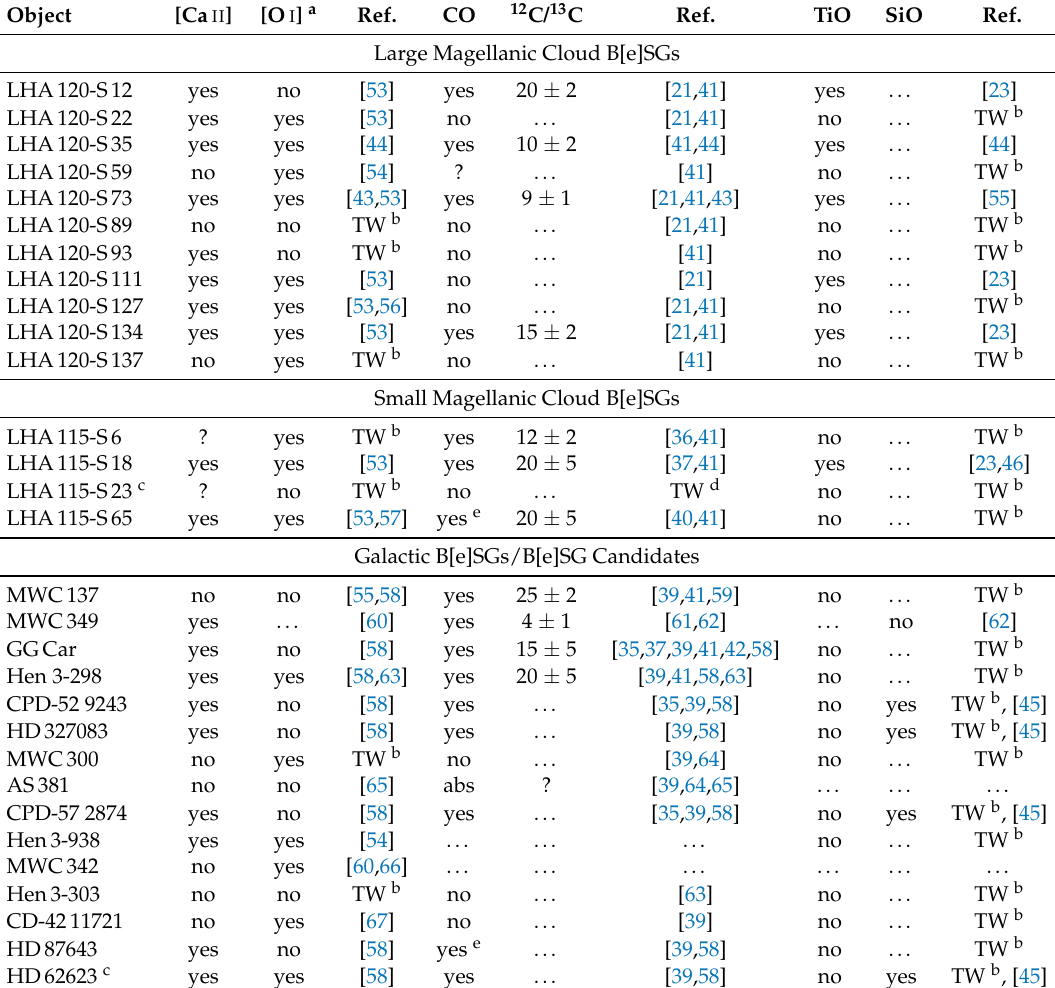
Table 2. Presence of disk tracers in the optical and near-IR spectra of the Galactic and Magellanic Cloud B[e]SG